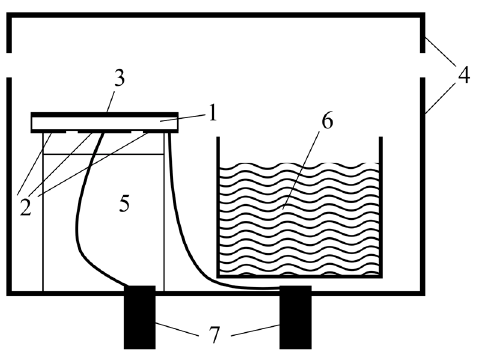
Figure 3. Gas chamber side view: 1—piezoresonator, 2—electrodes, 3—chitosan acetate film, 4— camera body and sealing cover, 5—solid support with top low impedance support, 6—volatile liq- 4—camera body and sealing cover, 5—solid support with top low impedance support, uid (water ammonia solution) in container, and 7—electrodes for the impedance analyzer port.